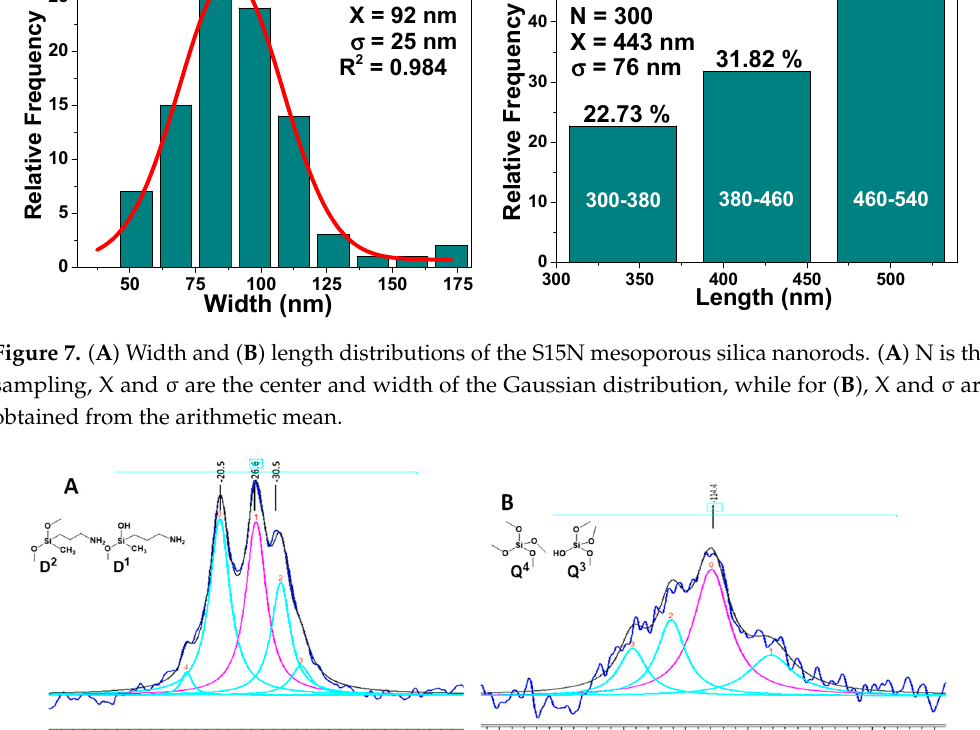
Figure 7. ( A ) Width and ( B ) length distributions of the S15N mesoporous silica nanorods. ( A ) N is the sampling, X and σ are the center and width of the Gaussian distribution, while for ( B ), X and σ are obtained from the arithmetic mean.